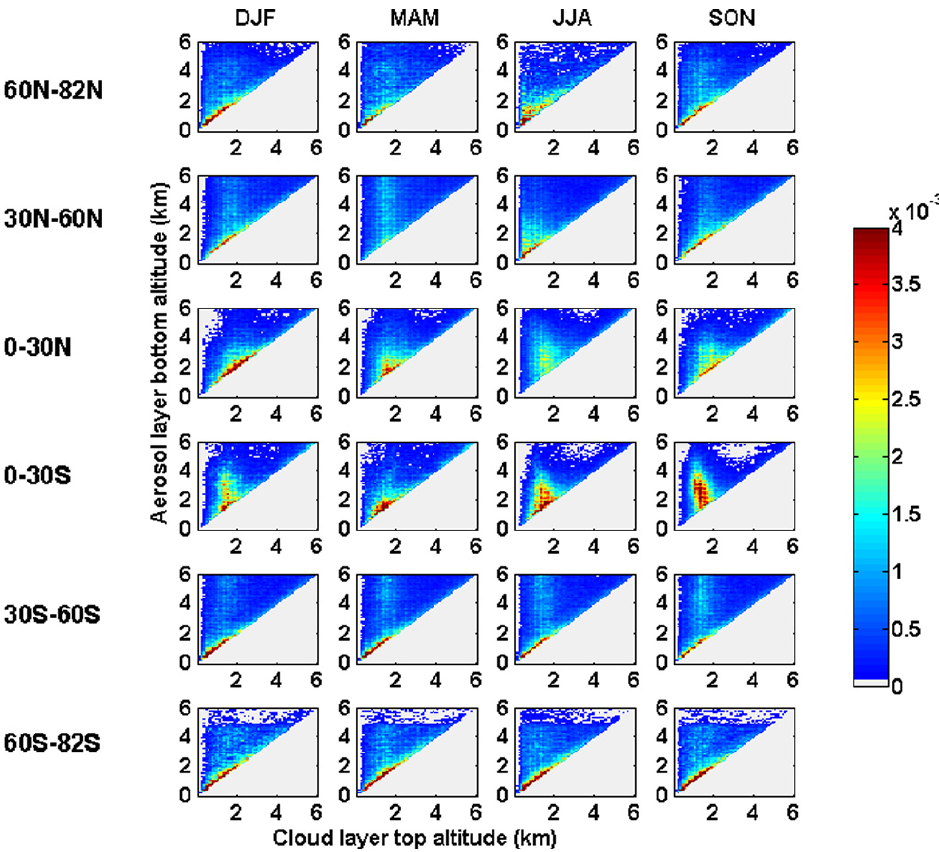
Fig. 7. The joint histograms of cloud layer top altitude and aerosol layer base altitude in overlapping cases when overlap from all aerosol types is considered. The bin size is 100m by 100m and the observations in each height-height bin are normalized by the total number of observations in the entire